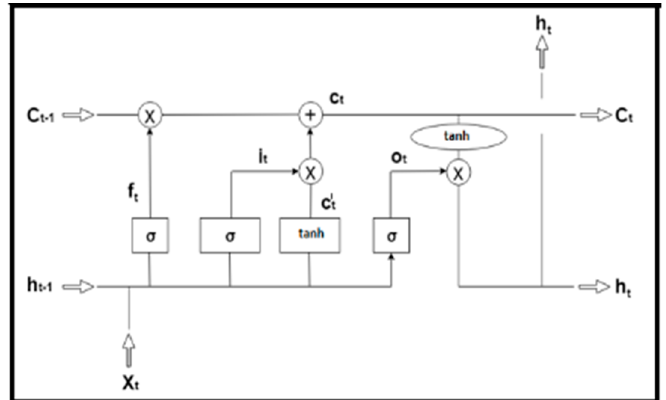
Figure 8. Diagrammatic representation of LSTM.